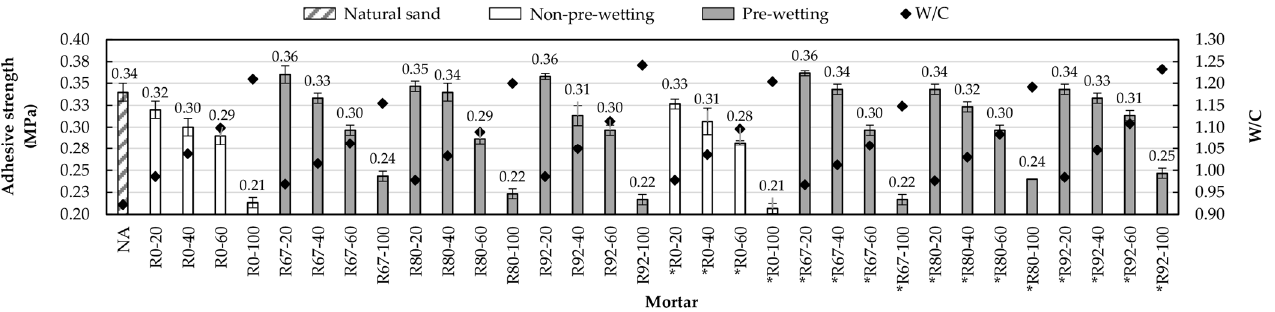
Figure 13. Adhesive strength and water/cement ratio.